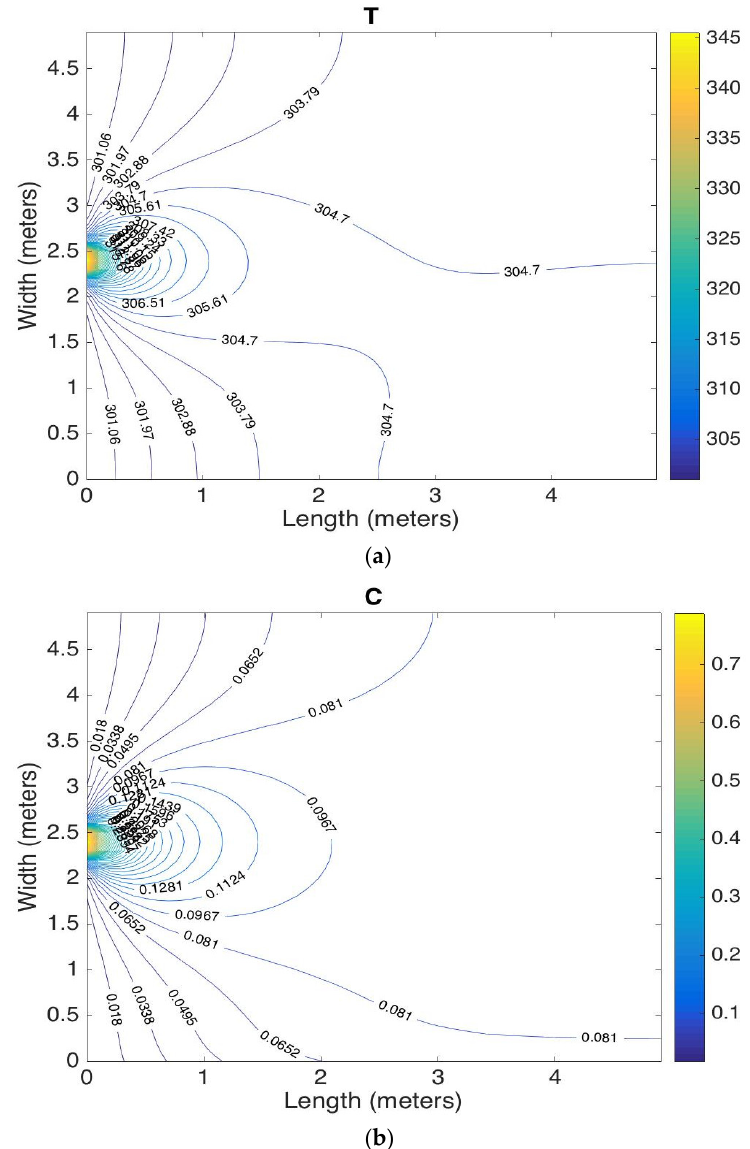
Figure 13. Contours of ( a ) temperature, and ( b ) concentration, of Case 2.